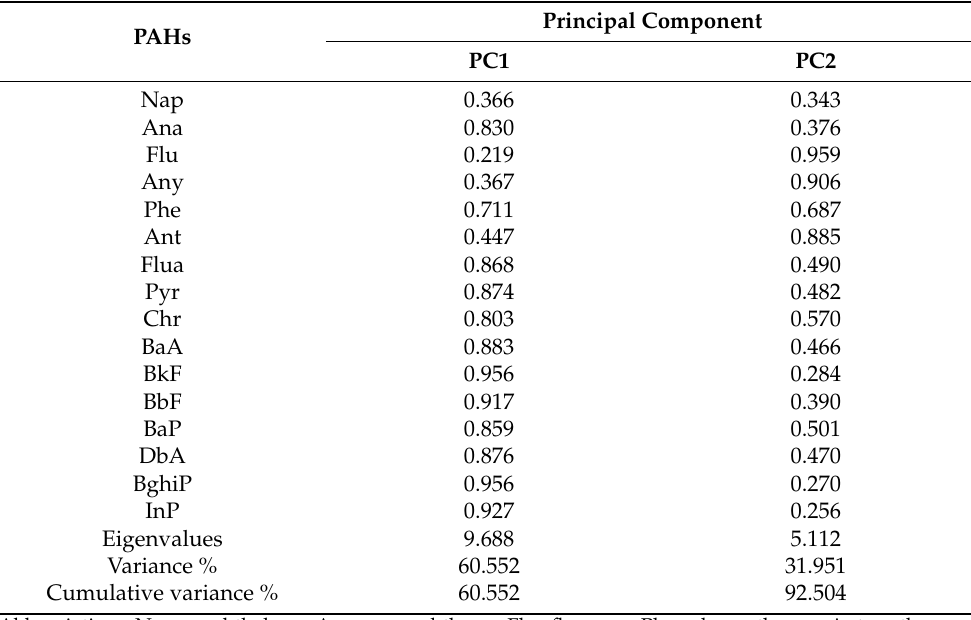
Cumulative variance % 60.552